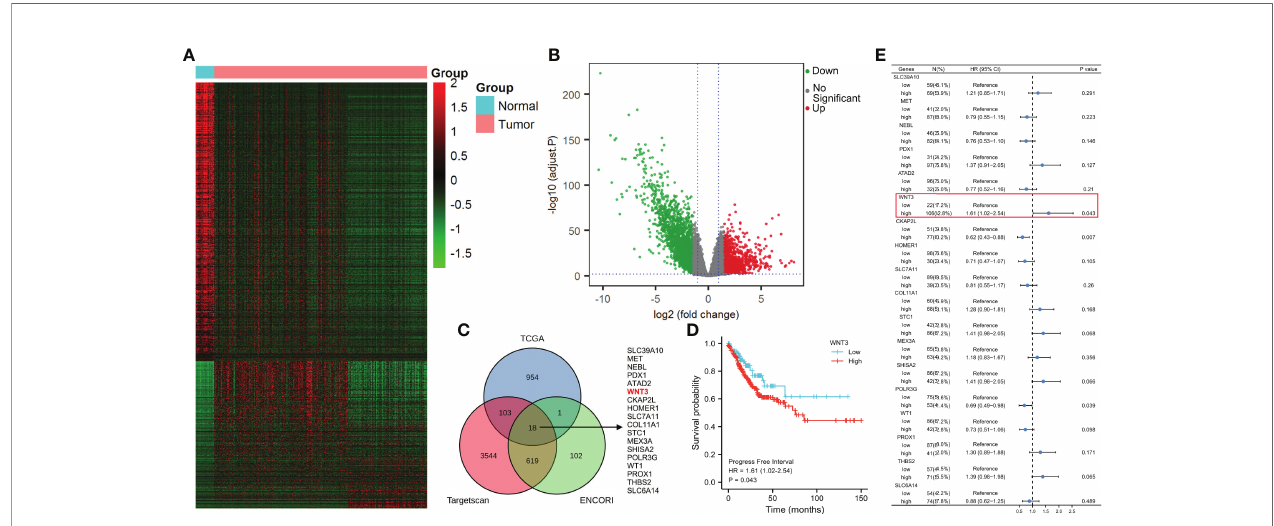
FIGURE 2 | WNT3 is upregulated in COAD tissue and is a predictor of poor prognosis of COAD. (A, B) Analysis of mRNA expression pro fi les was performed through data from TCGA. (C) Potential target genes of hsa-miR-374a-3p were predicted via taking the intersection of TCGA, TargetScan Human 7.2, and ENCORI. (D) Prognostic function of WNT3 in COAD was explored by analyzing data of TCGA. (E) PFI of 18 genes was presented by a forest